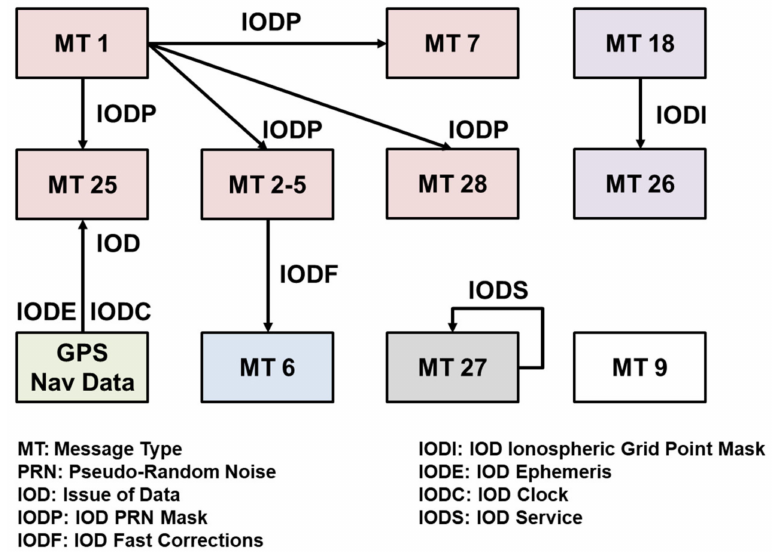
Figure 3. Interrelationship of the SBAS messages.